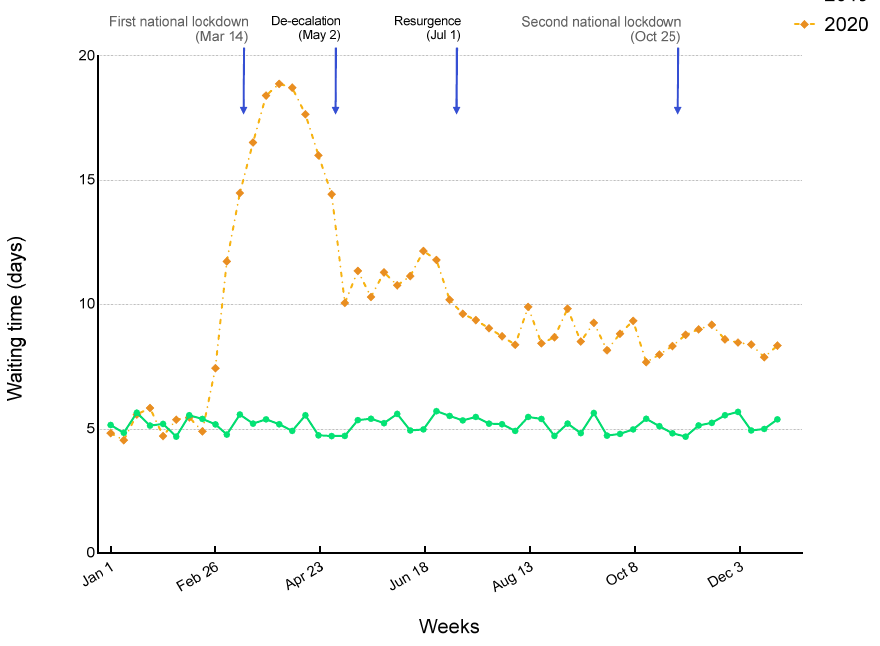
Figure 3. Trends in waiting times to invasive procedures by calendar week during COVID-19 pan- demic.